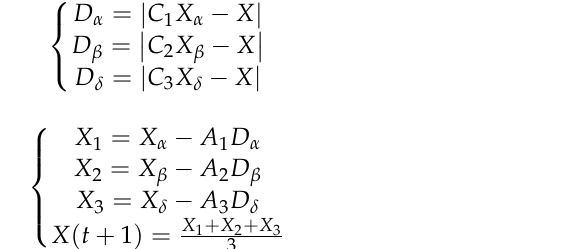
updated position of the grey wolf; X is the current position of the grey wolf; D α , D β and D δ are the distances between the current grey wolf and α , β , δ , respectively; |A| > 1 means that the grey wolves are in scattered mode to search for prey; and |A| < 1 means that the grey wolves focus on hunting for